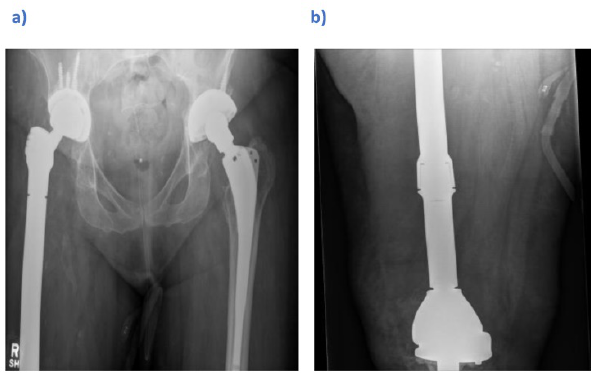
Figure 1 . Post-operative radiographs showing a custom-made right total femoral replacement (Stanmore Implants Worldwide, Stryker) a) Anteroposterior view of the pelvis b) Lateral view of the